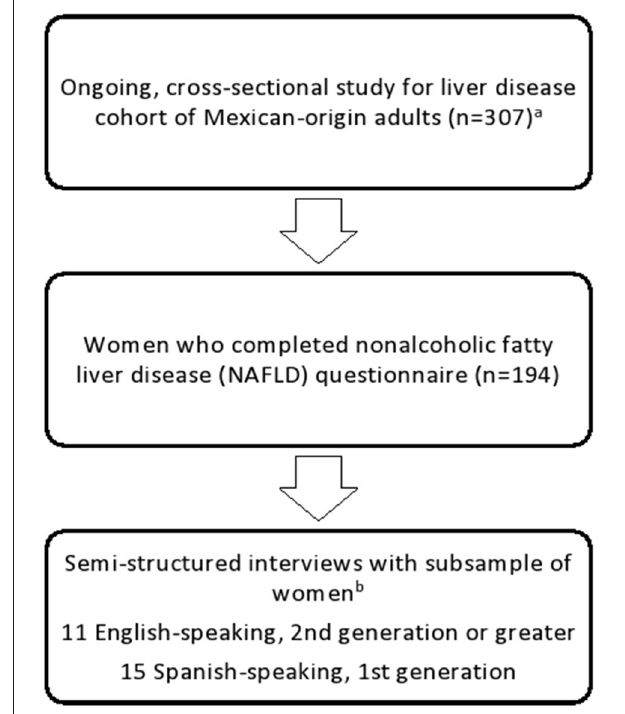
FIGURE 1 | Recruitment flow diagram for study quantitative and qualitative methods. a Eligibility criteria as follows: (1) self-identify as being